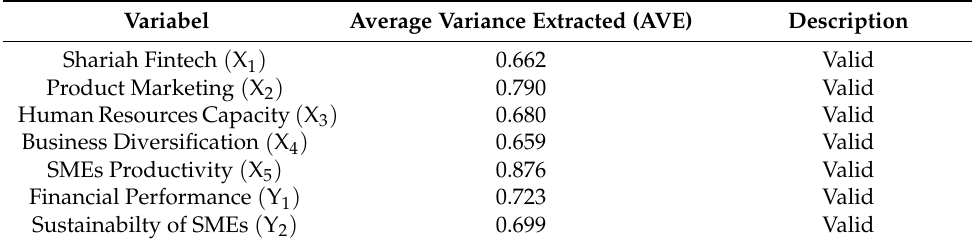
Table 4. Result of Validity Testing.